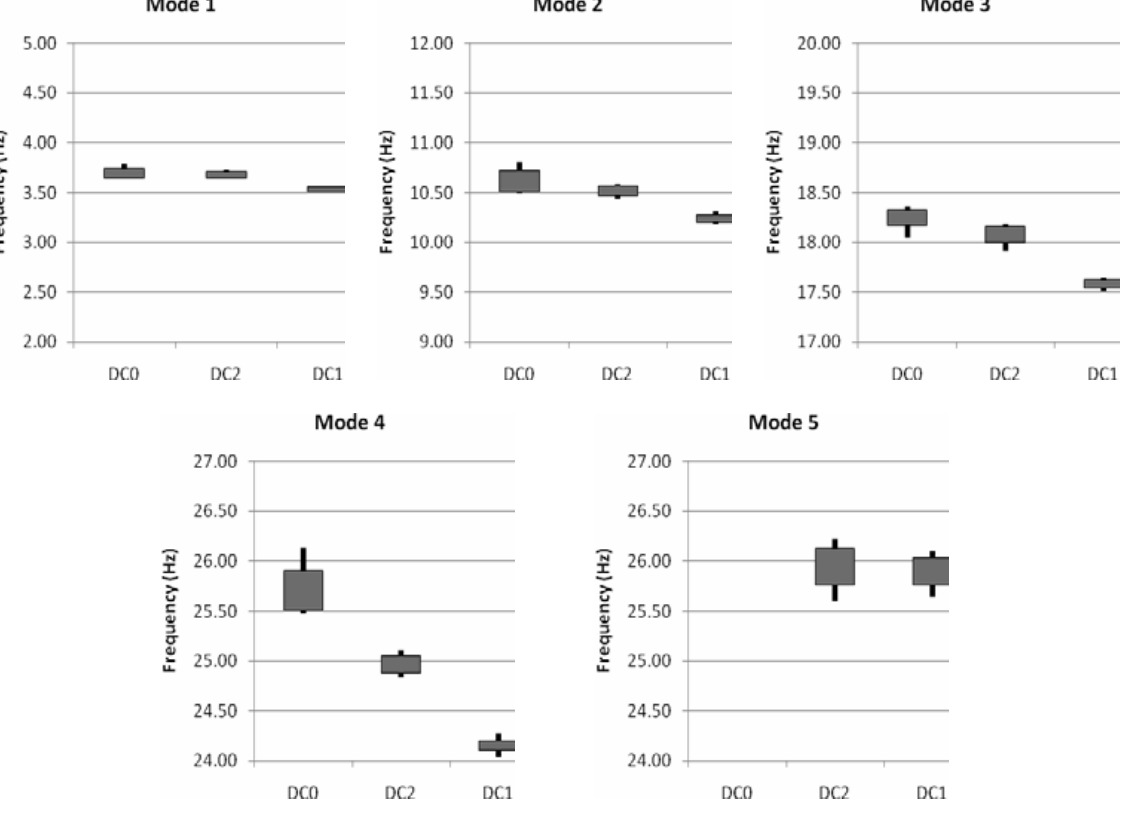
Fig. 12. Evolution of identified frequencies due to damage (FDD) ; solid bars signify µ ± σ range and error bars signify minimum and maximum values.